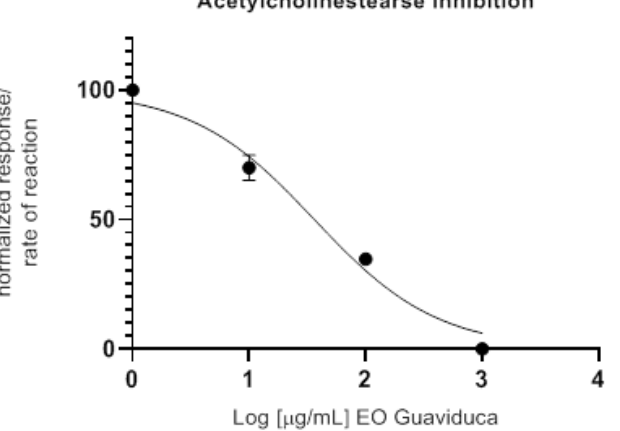
Figure 2. In vitro anticholinesterase activity of Piper carpunya essential oil expressed as log (concentration essential oil (EO)) vs. normalized response rate of reaction to calculate IC 50 value.